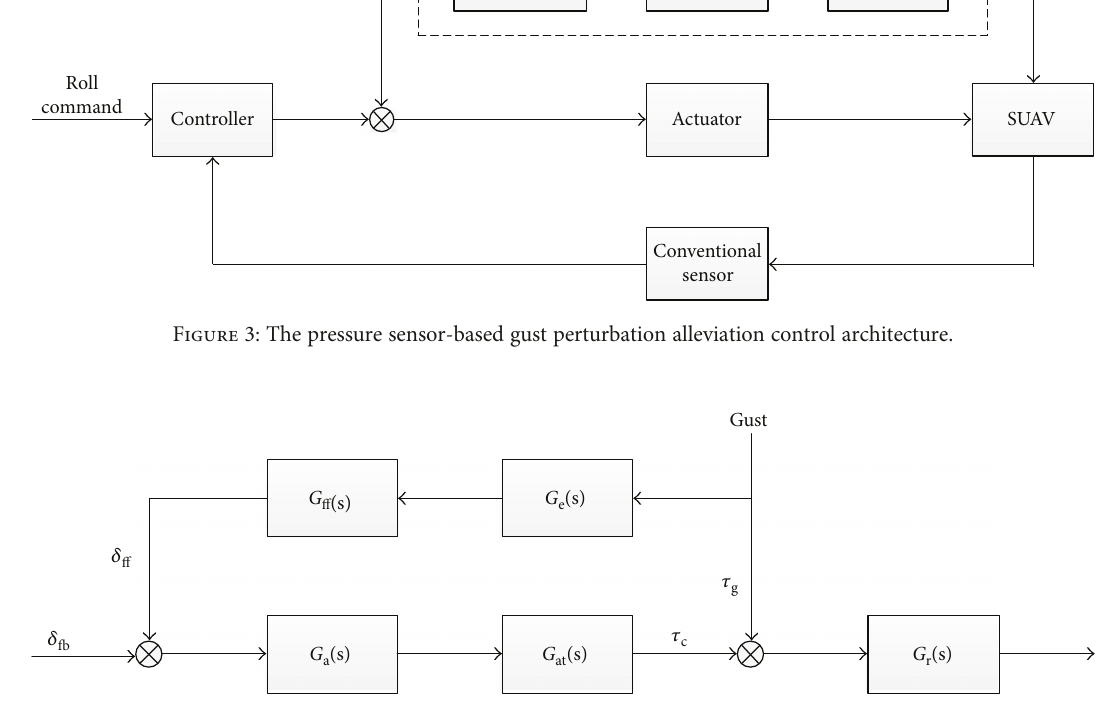
Figure 4: The block diagram for feedforward control